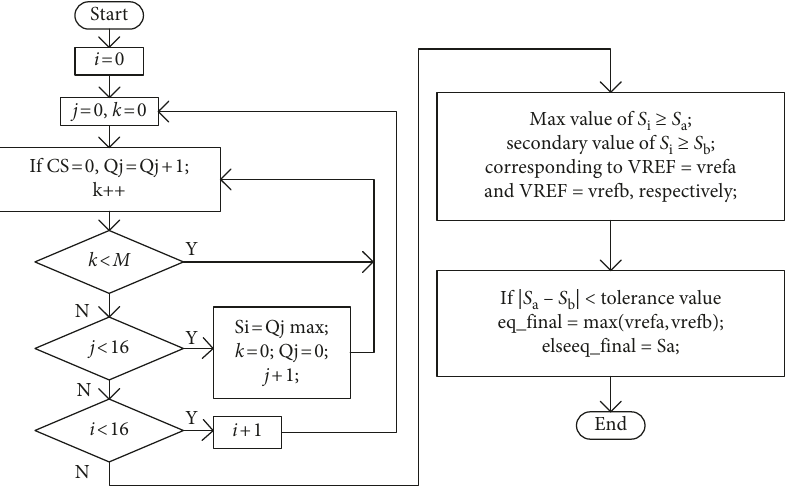
Figure 5: Proposed adaptive equalizer structure’s adaptation control flow